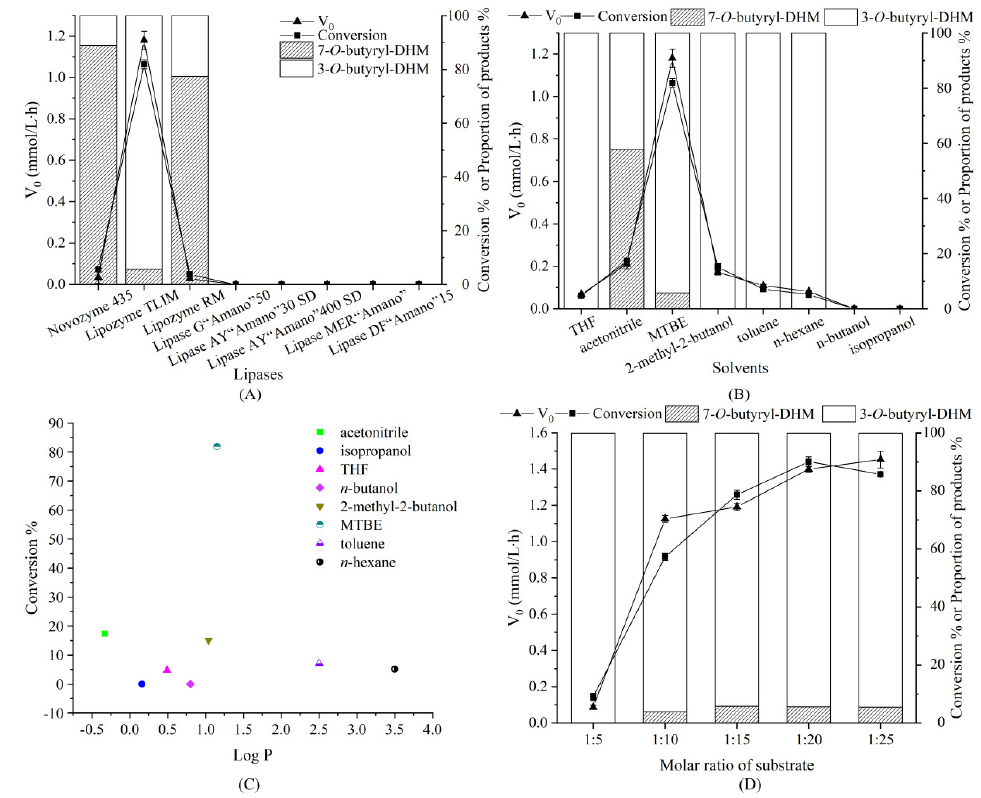
Figure 4. ( A ) Effect of lipase. Reaction conditions: DHM = 0.18 mmol, 50 ◦ C, 200 rpm, MTBE = 10 mL, vinyl butyrate = 2.7 mmol (molar ratio of DHM to vinyl butyrate = 1:15), lipase = 0.4 U/mg DHM, time = 24 h. ( B ) Effect of the solvent system. Reaction conditions: DHM = 0.18 mmol, 50 ◦ C, 200 rpm, Lipozyme TL IM = 0.4 U/mg DHM, vinyl butyrate = 2.7 mmol (molar ratio of DHM to vinyl butyrate = 1:15), solvent volume = 10 mL, time = 24 h. ( C ) Relationship between the log p value of eight solvent systems and conversion of DHM at 24 h. ( D ) Effect of molar ratio of substrate. Reaction conditions: DHM = 0.18 mmol, Lipozyme TL IM = 0.4 U/mg DHM, 50 ◦ C, 200 rpm, MTBE = 10 mL, time = 24 h.